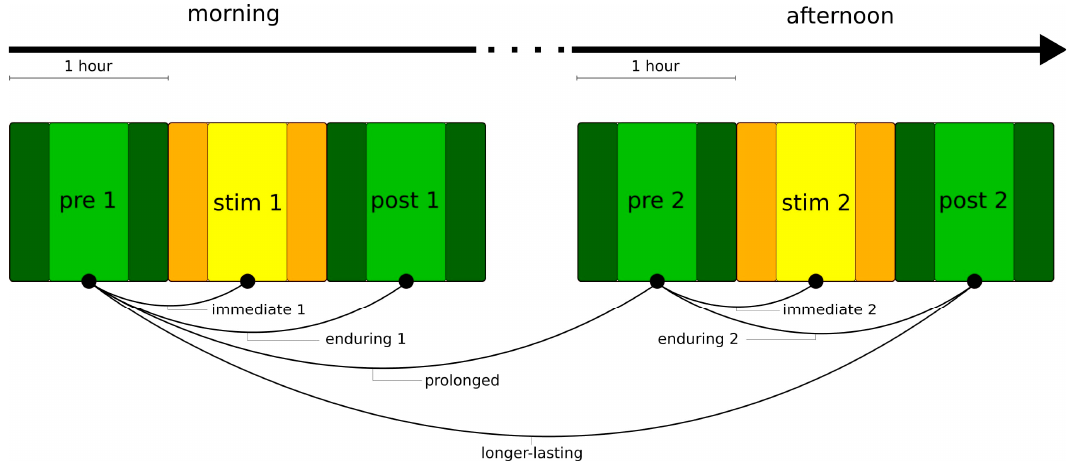
Figure 1. Examination schedule to probe for short and longer-lasting taVNS-induced changes in evolving functional brain networks. The schedule consisted of two 1 h stimulation phases (morning: stim 1 and afternoon: stim 2; yellow-shaded blocks) each phase was preceded and followed by a pre- and post-stimulation phase, each lasting one hour (green-shaded blocks). During each of the 3 h blocks, subjects continued laid-back activities (no other activation methods applied, no eating) and they continued performing daily activities during the break (no other activation methods applied). The whole examination schedule (including the break) was embedded into a continuous video-EEG-recording. In our analyses, we neglected data from the first and last 15 min of each phase (darker colours) in order to remove possible transient effects (e.g., due to movements or expectation effects).